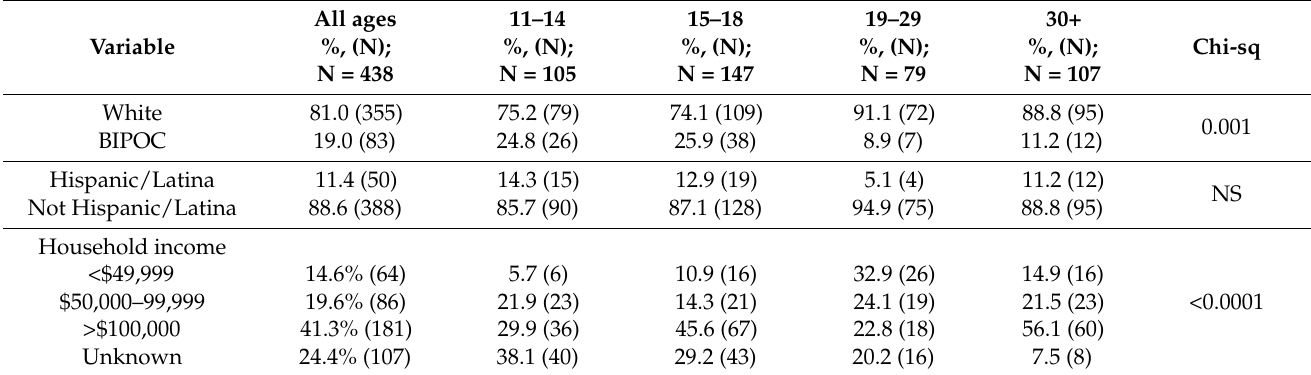
Table 1. Demographic characteristics of the sample.